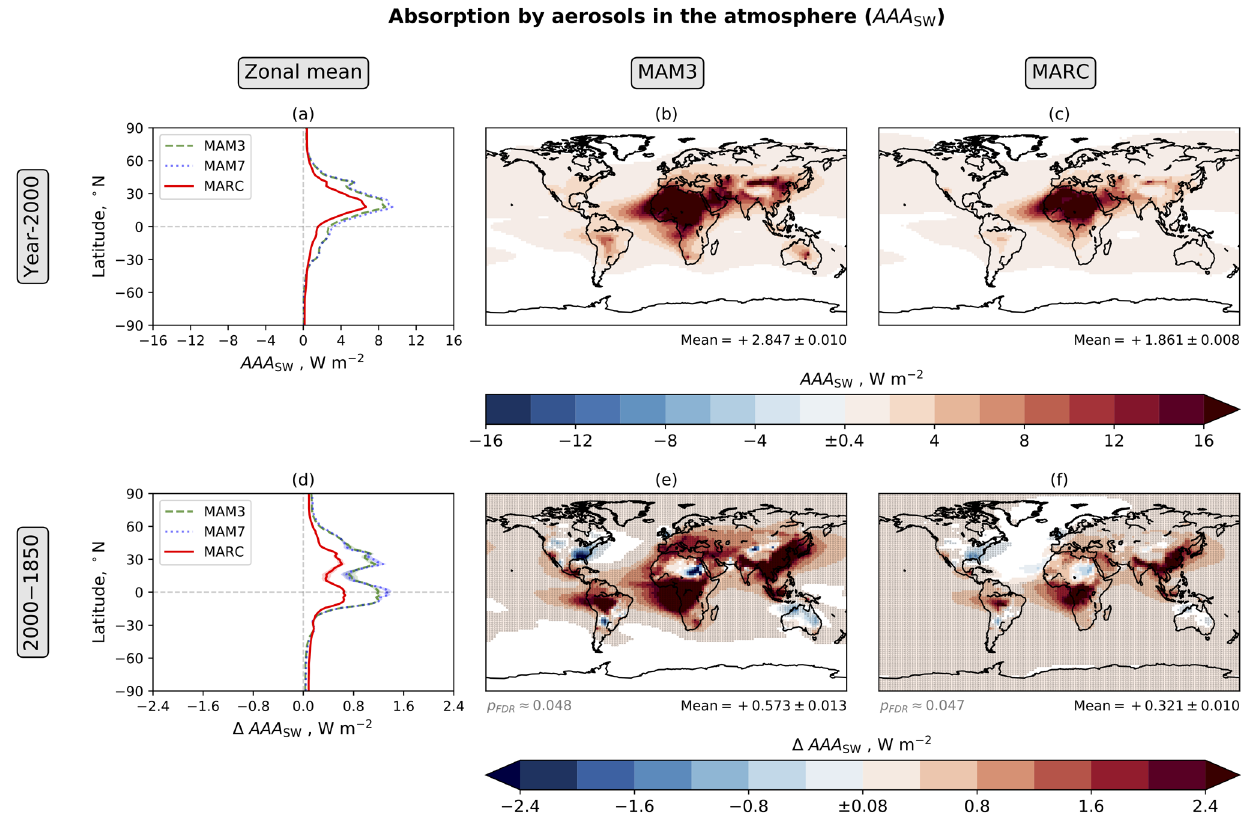
Figure 9. Annual mean absorption by aerosols in the atmosphere (AAA SW ; Eq. 8). The figure components are explained in the Fig. 2 caption. For all four maps, white indicates differences with a magnitude less than the threshold value in the centre of the corresponding colour